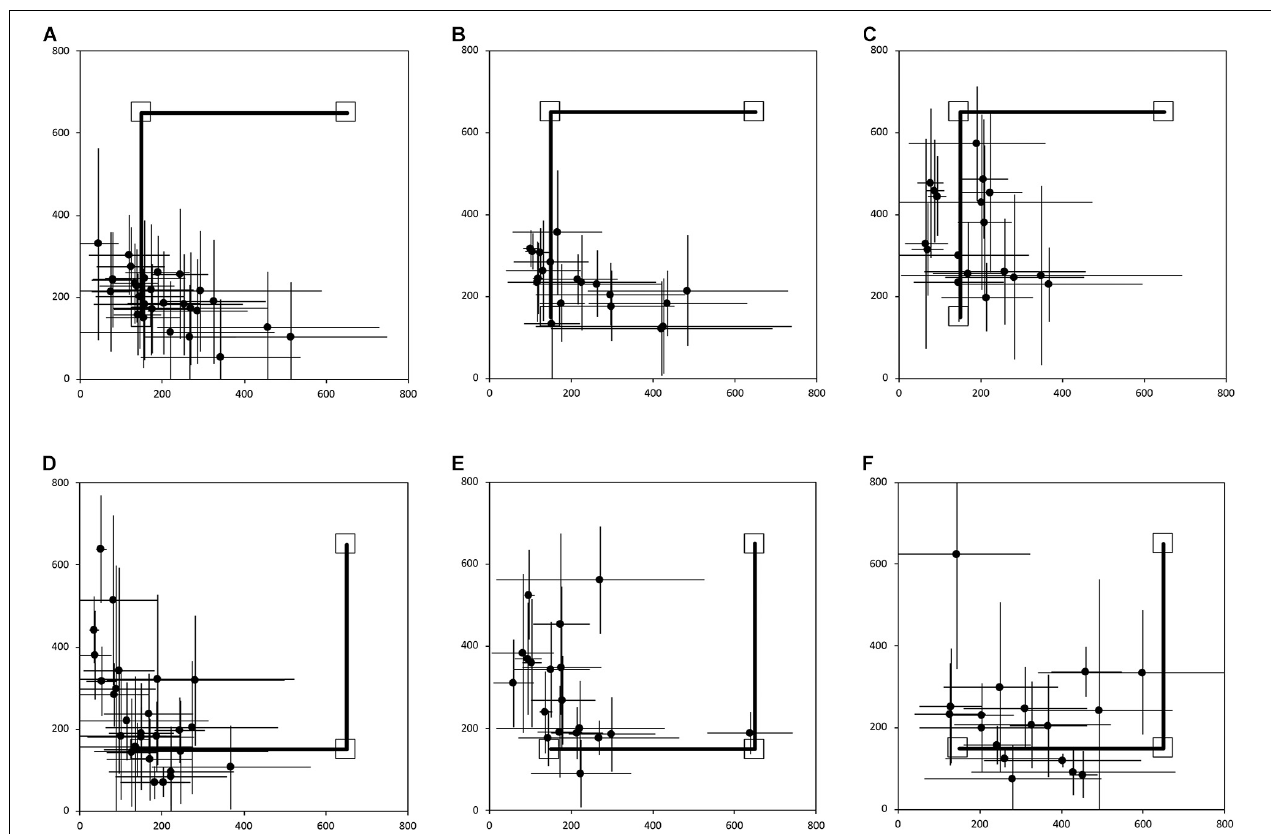
FIGURE 3 | Average end location of individual participants’ return paths, following a two-legged 10 m angled outward journey in the egocentric homing task. The horizontal and vertical error bars represent the standard deviation for each individual across one session. The solid line indicates the outward angled path. The top right square indicates the starting point of the return path. The bottom left square indicates “home.” In Session 1, participants were guided by the left arm, and in Session 2 they were guided by the right arm. (A) TD, Session 1. (B) DS, Session 1. (C) WS, Session 1. (D) TD, Session 2. (E) DS, Session 2. (F) WS, Session 2. Room size: 800 cm × 800